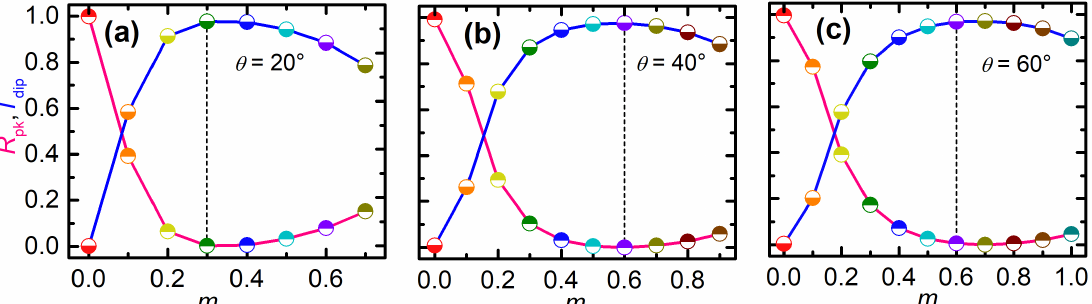
Figure 8. Peak reflectance (red curves) and dip transmittance (blue curve) for specific incidence angles and wavelengths as a function of the GST crystallization fraction. The results are extracted from Figure 7 for ( a ) θ = 20 ◦ and λ = 3.759 µm, ( b ) θ = 40 ◦ and λ = 4.329 µm, and ( c ) θ = 60 ◦ and λ = 4.767 µm. The vertical dashed lines indicate the GST crystallization fraction for near-unitary peak reflectance or near-zero dip transmittance: ( a ) m = 0.3 and ( b , c ) m =